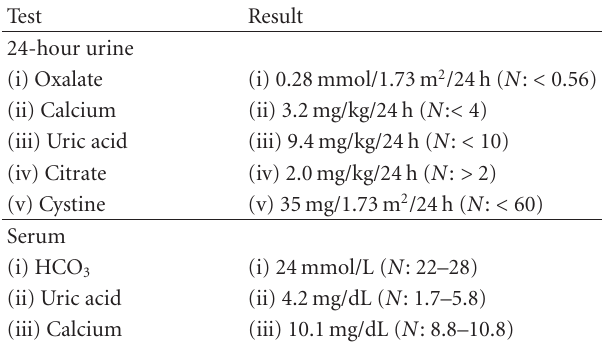
Table 1: Metabolic evaluation for nephrolithiasis. Test Result 24-hour